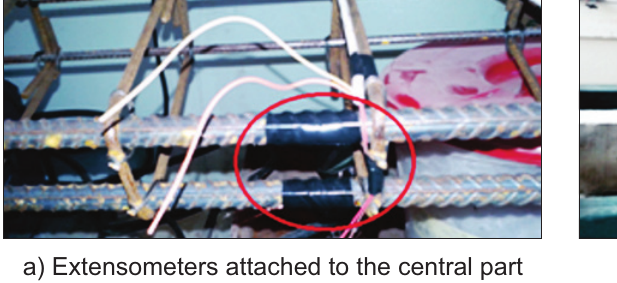
a) Extensometers attached to the central part of the longitudinal tension reinforcement